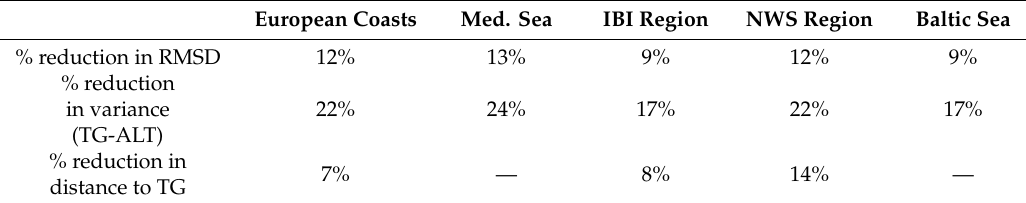
Table 6. Summary of the improvements (%) of the Sentinel-3A mission in comparison with tide gauges in terms of the lower RMSD, lower variance of the differences (altimetry—tide gauge), and lower mean distance between the most correlated altimetry point and tide gauges with respect to Jason-3 in the European coasts and the different sub-regions investigated. The analysis is similar to that shown in Tables 1 and 2 (last column), but using filtered SLA data.